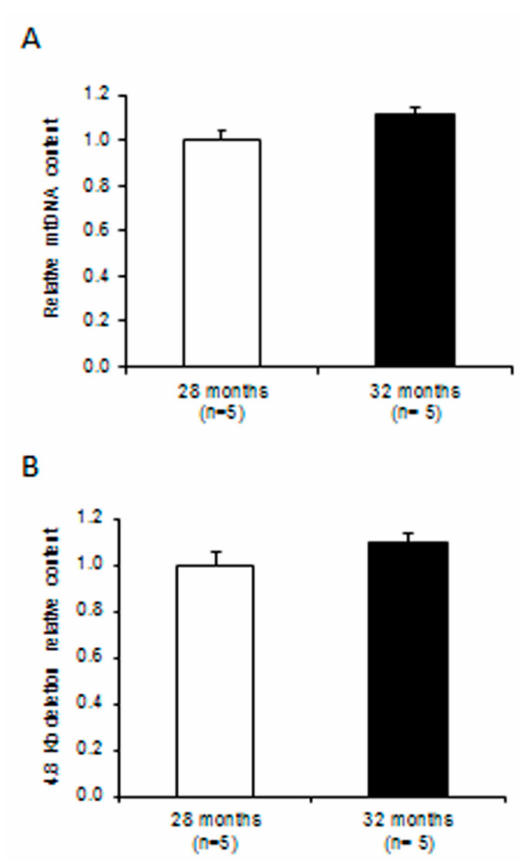
Figure 2. Relative contents of mitochondrial DNA (mtDNA) and of the 4.8 Kb mtDNA deletion in liver from 28- and 32-month-old rats. ( A ) Relative mtDNA content and ( B ) relative 4.8 Kb deletion content determined by quantitative PCR (qPCR). (A,B) Bars represent the mean value and SEM of two independent experiments conducted in triplicate. The comparisons were made with respect to the value of the 28-month-old rats, fixed as 1; n = number of analyzed